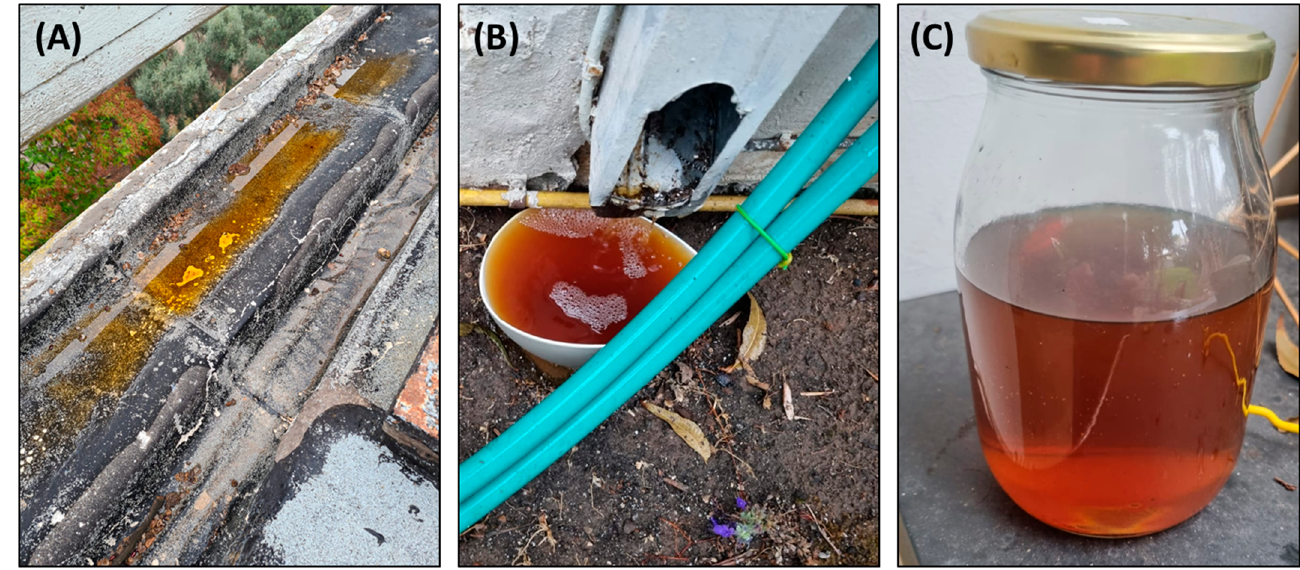
Figure 2. Samples of the brownish roof water obtained at the very first flush. ( A ) Ponded water at the rooftop, ( B ) drained brownish water in the gutter, and ( C ) collected water at the first flush of the season.